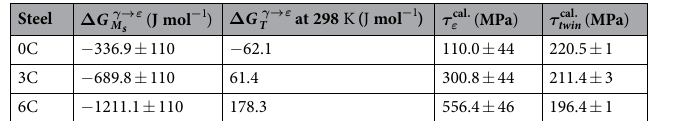
Table 2. Difference in chemical Gibbs free energy between γ and ε phases at the ε martensite start ( M s ) temperature and at 298 K, and critical resolved shear stresses calculated for both mechanical twinning and ε martensitic transformation occurring during plastic deformation in 0C, 3C and 6C